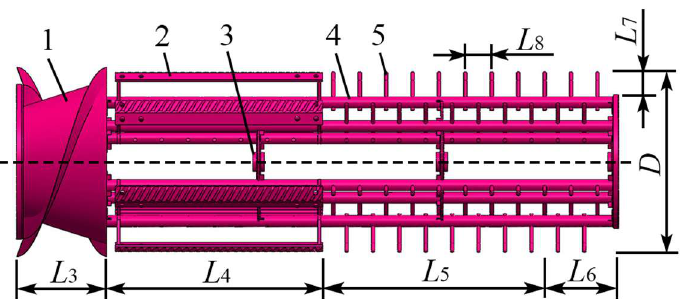
Figure 6. Schematic diagrams of the combined longitudinal axial flow threshing drum with ribs-rod teeth: (1) Screw feed head. (2) Striker threshing element. (3) Spoke disc. (4) Crossbar. (5) Rod tooth threshing element. Note: L 4 is the length of the striker section in mm; L 5 is the length of the separating section in mm; L 6 is the length of the grass discharge section in mm; L 7 is the working length of the rod teeth in mm; L 8 is the distance between the rod teeth in mm.